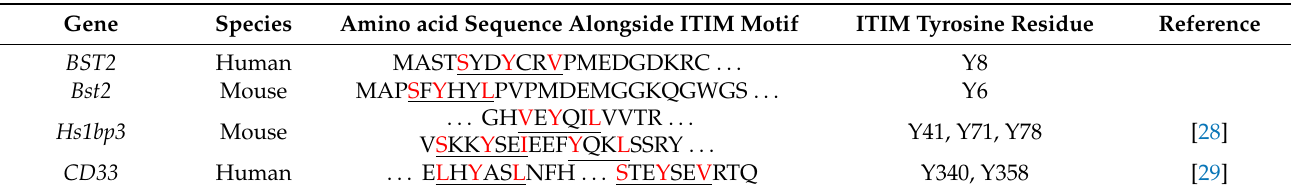
Table 1. ITIM motif of the cytoplasmic tail domain in BST2.